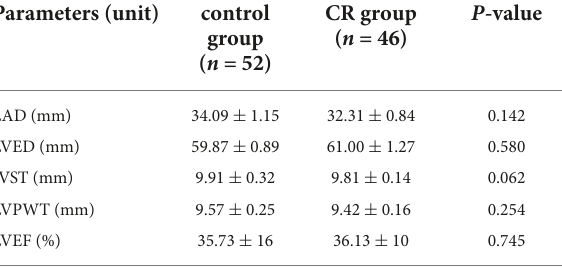
TABLE 2 Comparison of baseline parameters of echocardiography between control group and CR group.